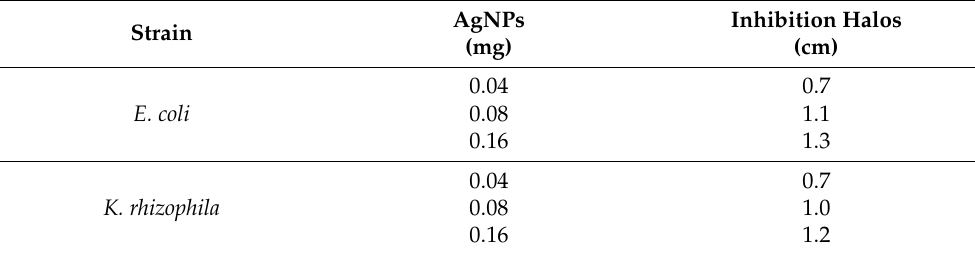
Table 2. Antimicrobial activity of AgNPs against E. coli and K. rhizophila . Strain